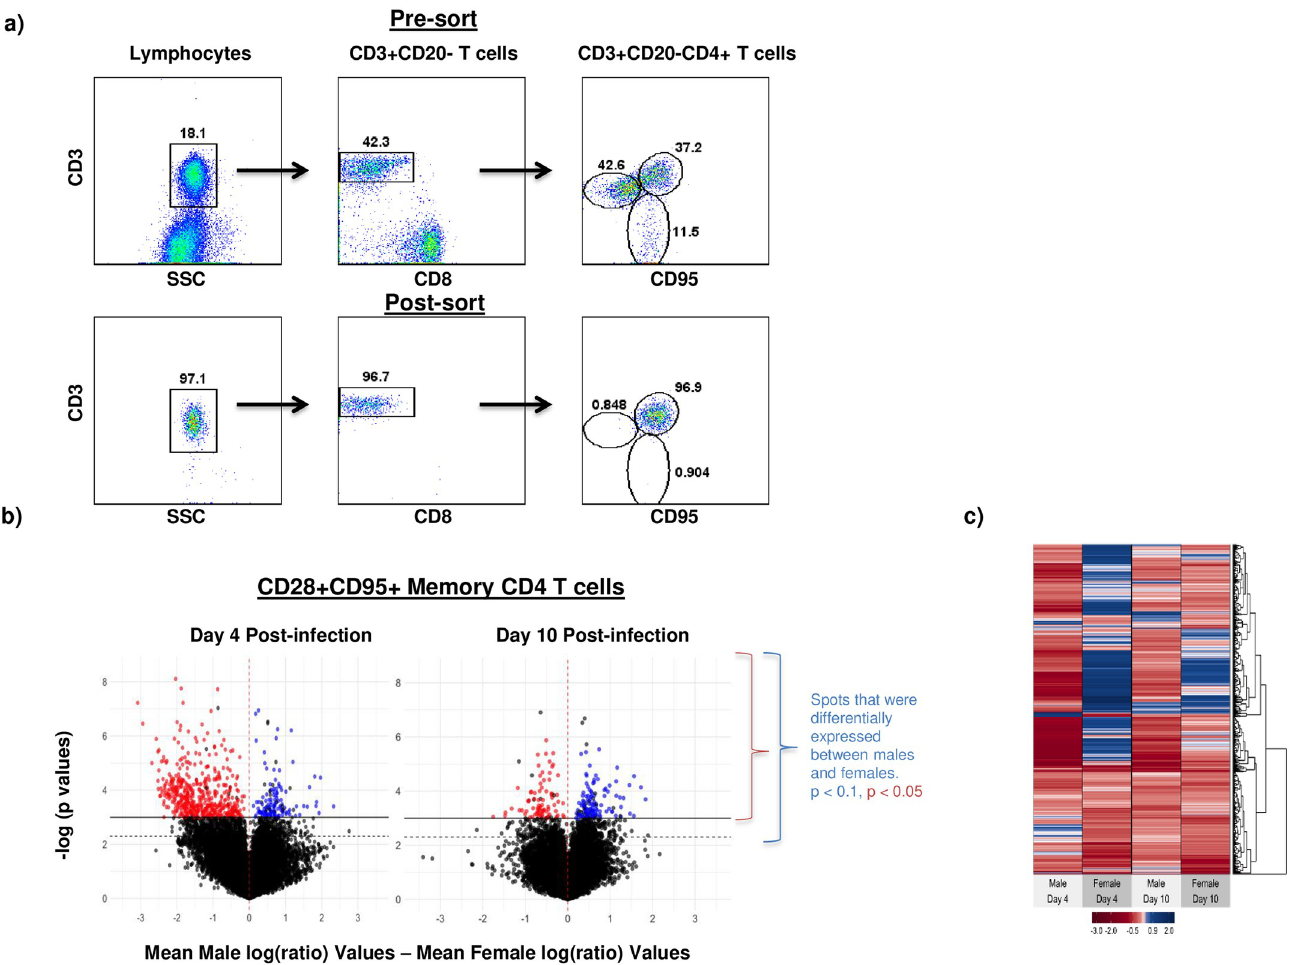
Fig 2. Female macaques differentially regulate significantly larger number of genes during acute SIV infection as compared to male macaques. (a) Representative dot plots showing the sorting strategy (Pre-sort) used to obtain populations of central memory (CM) CD4 T cells and the purity of the CM CD4 T cells (Post-sort). (b) Volcano plots and (c) heat map generated using genes that were differentially regulated in CM CD4 T cells from male (n = 4) and female (n = 4) macaques at day 4 and 10 post SIV infection. Each animal’s day 0 sorted CM CD4 T cell sample was used to normalize the same animals day 4 and 10 post SIV infection sorted samples. For (b), the mean log2 signal ratio (e.g. log2(Day 4 signal/ Day 0 signal)) for each gene on the microarray was calculated for each gender (4 animals per gender) and the difference in mean ratio values was computed between males and females and plotted along the x-axis. Genes that exhibited significant differences in expression between males and females are plotted above the horizontal significance line (solid line: p < 0.05; dashed line: p < 0.1). Red colored points indicate genes that were more upregulated in females than males, and blue points represent genes that were more upregulated in males than females. Black points falling above the significance lines indicate those points that are more down regulated between males and females. Black points above the significance line represent genes that were significantly more down regulated between males (left side) and females (right side).